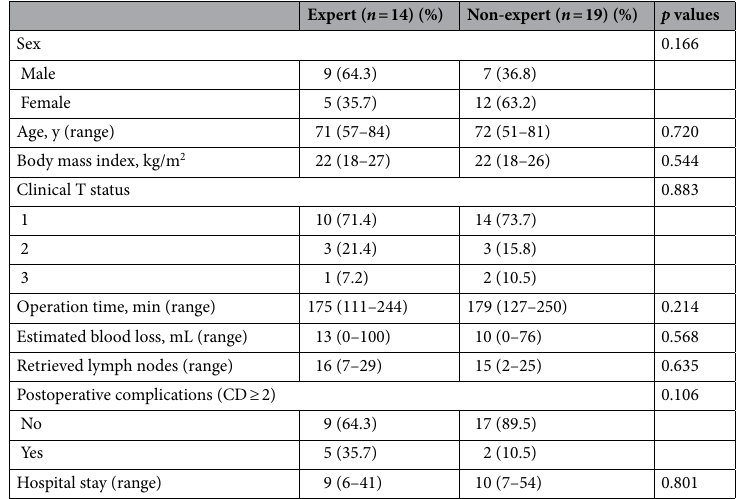
Table 4. Comparison of clinical characteristics in SILS performed by an expert or a non-expert. Data are presented as numbers of patients or medians (range). Differences in categorical variables were compared using Fisher’s exact test or the chi-squared test, as appropriate. Differences in continuous variables were analyzed with the Mann–Whitney U -test. SILS single-incision laparoscopic surgery.